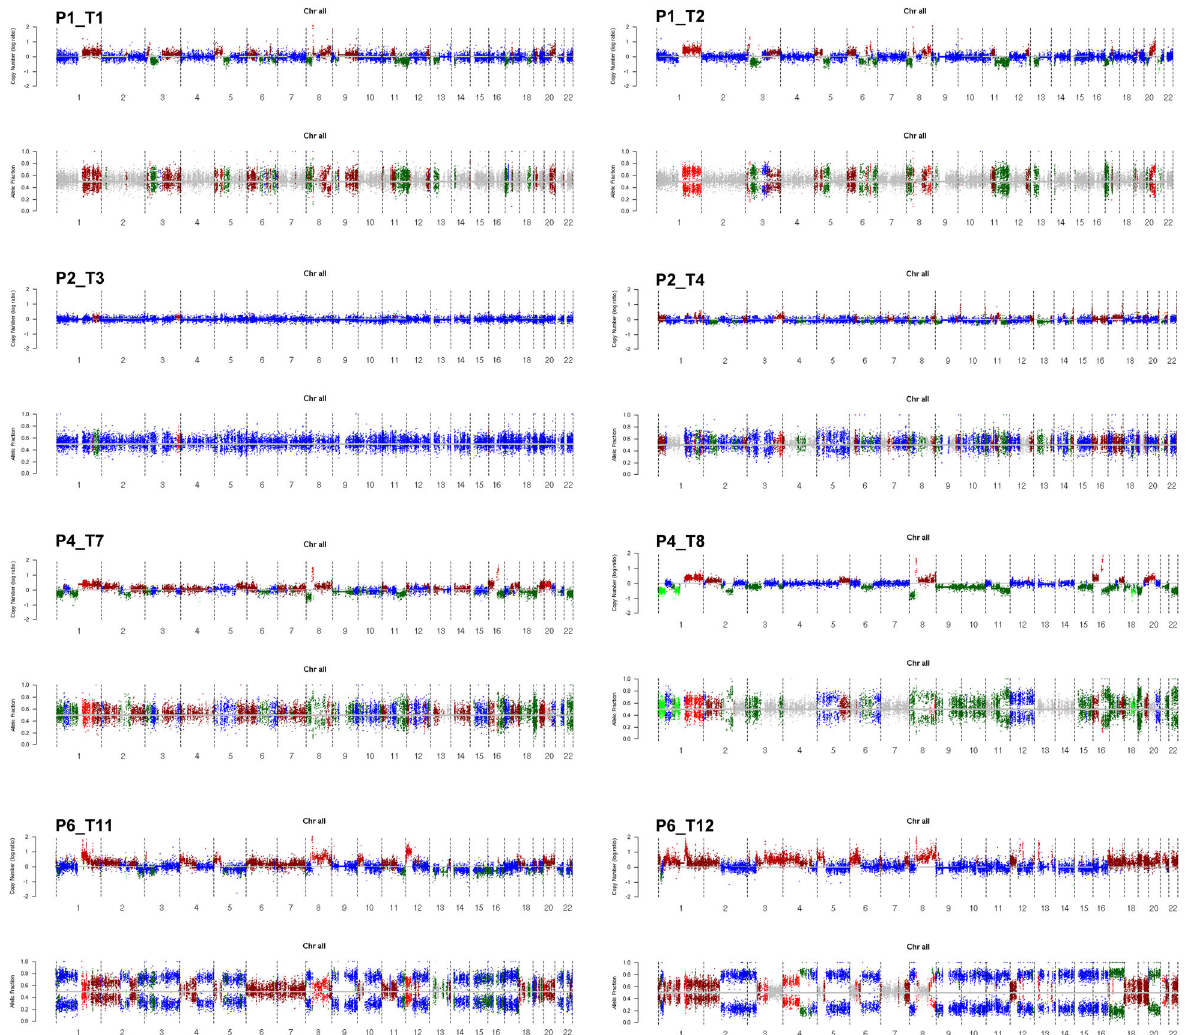
Fig. 2 Graphical representations of copy number alterations (CNAs) and allelic fractions (AFs) from two tumors per patient. Two tumors are obtained from each patient, represented on the left and right of the fi gure. Data from four patients with matched normal samples are available, and four sets of CNAs and AFs plots are presented. Within each set, the CNA plot is shown above the AF plot. For the CNA plot, the y -axis is the log2 ratio of the copy numbers of tumor to normal sample, both normalized for read depth. Points close to 0 (midline) represent no change in copy number, above 0 are copy gains, and below 0 are deletions. Regions are colored as follows: bright green (homozygous deletion), green (hemizygous deletion), blue (diploid heterozygous or copy-neutral loss of heterozygosity), dark red (copy number gain), and red (allele-speci fi c CNA, unbalanced CNA, balanced CNA). The x -axis represents chromosomes. For the AF plot, the y -axis is the frequency of the reference allele in a germline heterozygous SNV, and the expected heterozygous frequency of 0.5 is the midline. Data points close to